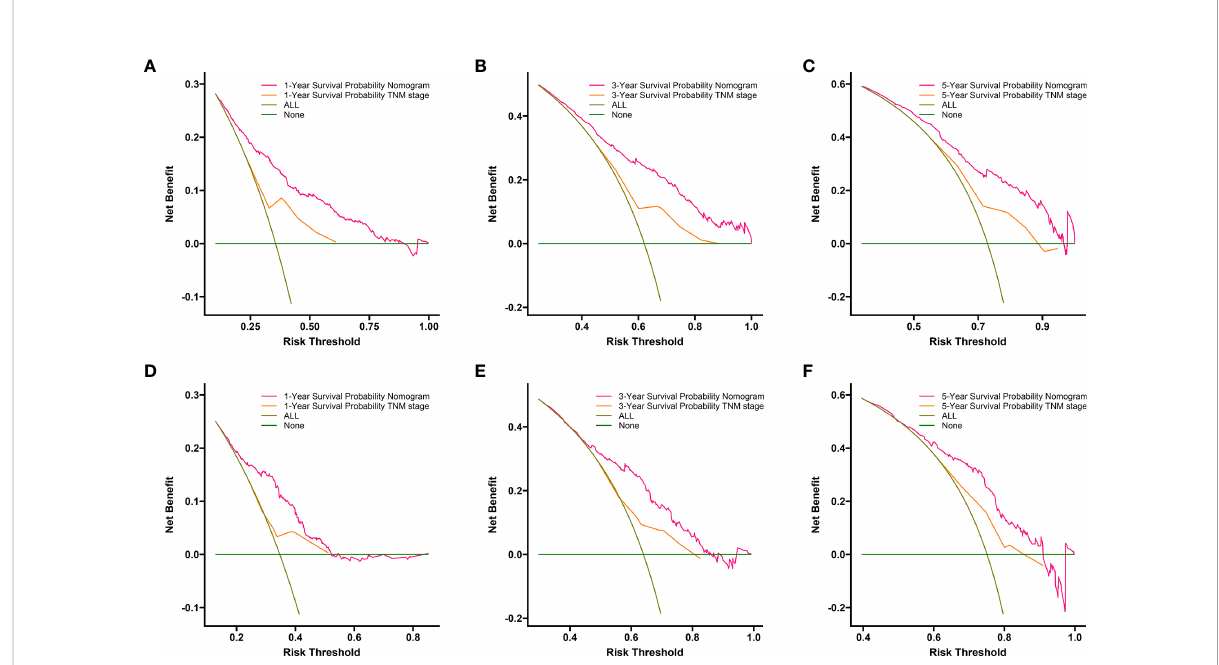
FIGURE 6 DCA of the nomogram and AJCC TNM staging for 1-year (A) , 3-year (B) and 5-year (C) CSS in training set, and for 1-year (D) , 3-year (E) and5- year (F) CSS in the validation set. The red line represents the nomogram. The orange line represents AJCC TNM stage. CSS, cancer speci fi c survival; DCA, decision curve analyses; AJCC, American Joint Committee on